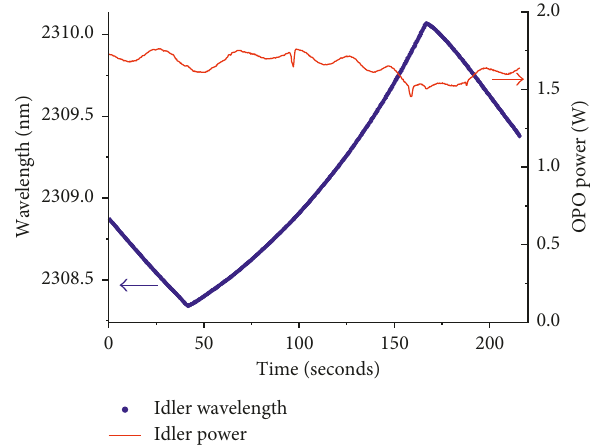
Figure 2: Continuous tuning of the idler wavelength (blue line) using a combination of pump-laser tuning and crystal-temperature tuning (crystal temperature is tuned over about 2 ° C). The idler output power is also shown (red